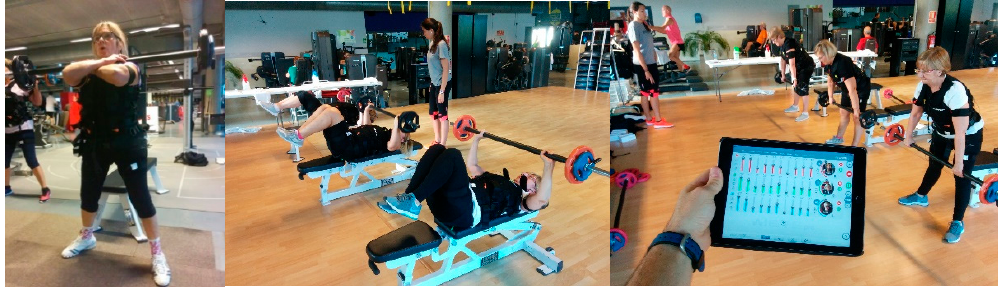
Figure 2. Strength training program exercises .